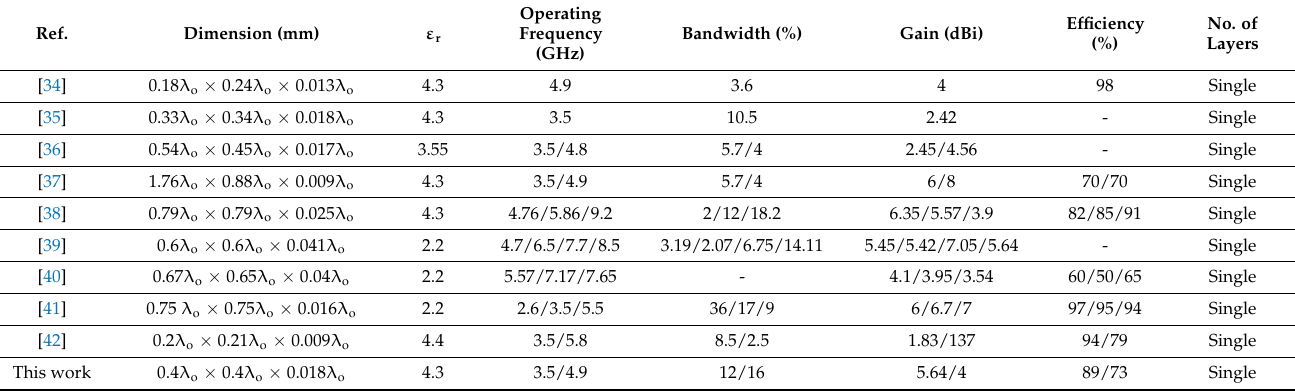
Table 3. Comparative study of the proposed antenna with the existing designs.